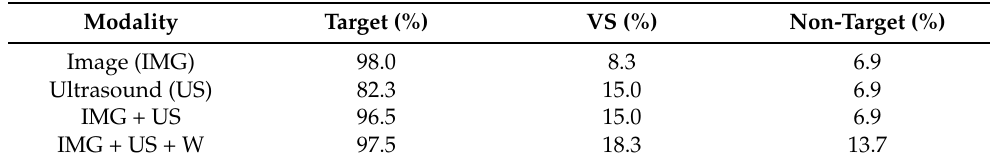
Table 4. Classification results using multi-modal inputs in a real-world database. W denotes the weight modality, target denotes the accuracy in target class objects in Figure 5, VS denotes the fraud detection rate for visually similar fraud inputs, and non-target denotes the fraud detection rate for non-target